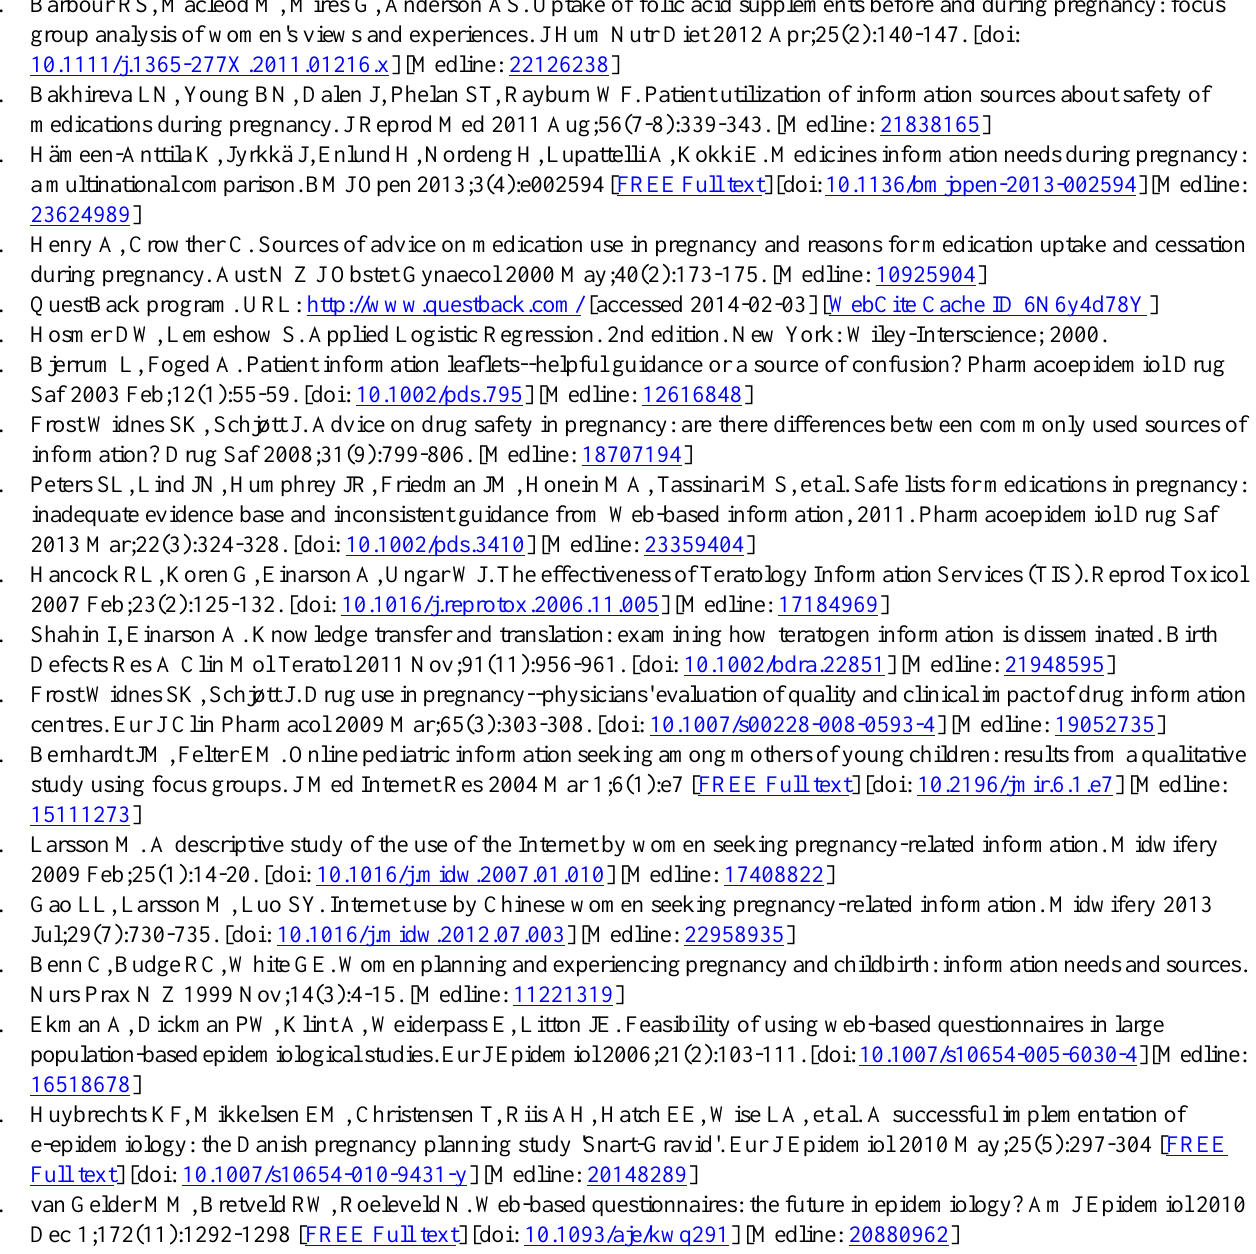
TIS: teratology information